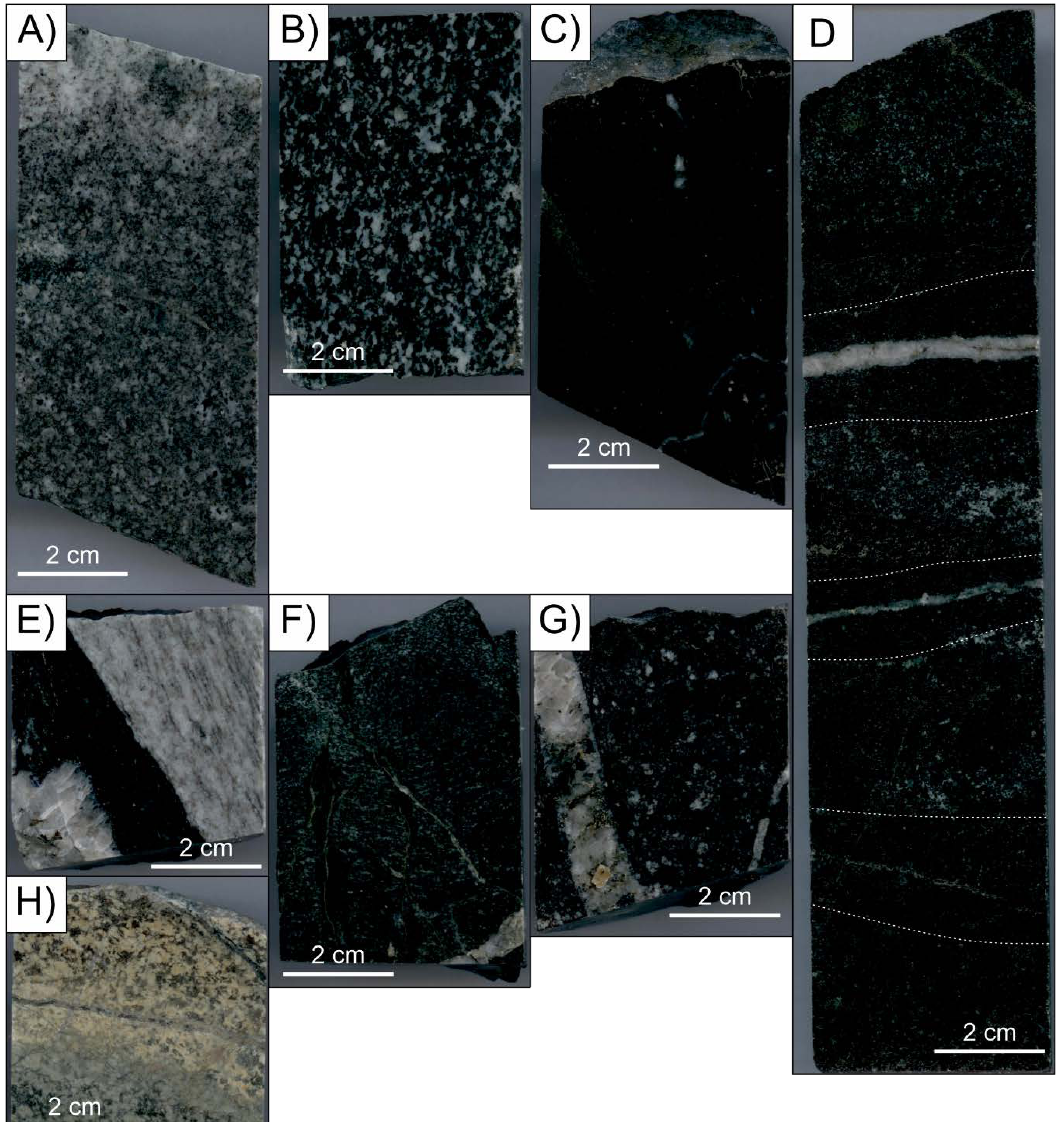
Figure 3. Images of representative polished slabs of rock types from the Sisson Brook Deposit. ( A ) Diorite, ( B ) gabbro, ( C ) argillite, ( D ) diabase dyke with visible alteration surrounding veins (selvage boundaries marked by white dashed line), ( E ) felsic augen tuff in contact with mafic tuff, ( F ) mafic tuff, ( G ) mafic crystal tuff, ( H ) sericitized gabbro showing altered selvage surrounding small carbonate and quartz veins.